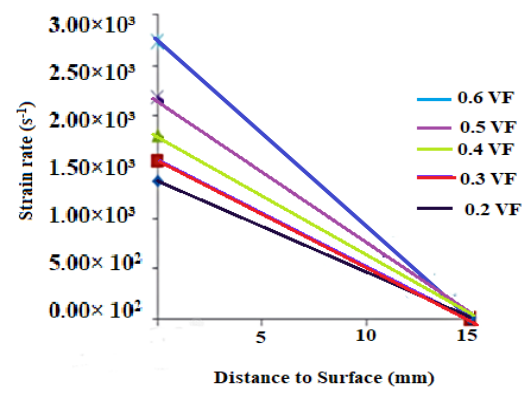
Figure 46. Impact of volume fraction in strain rate [247].